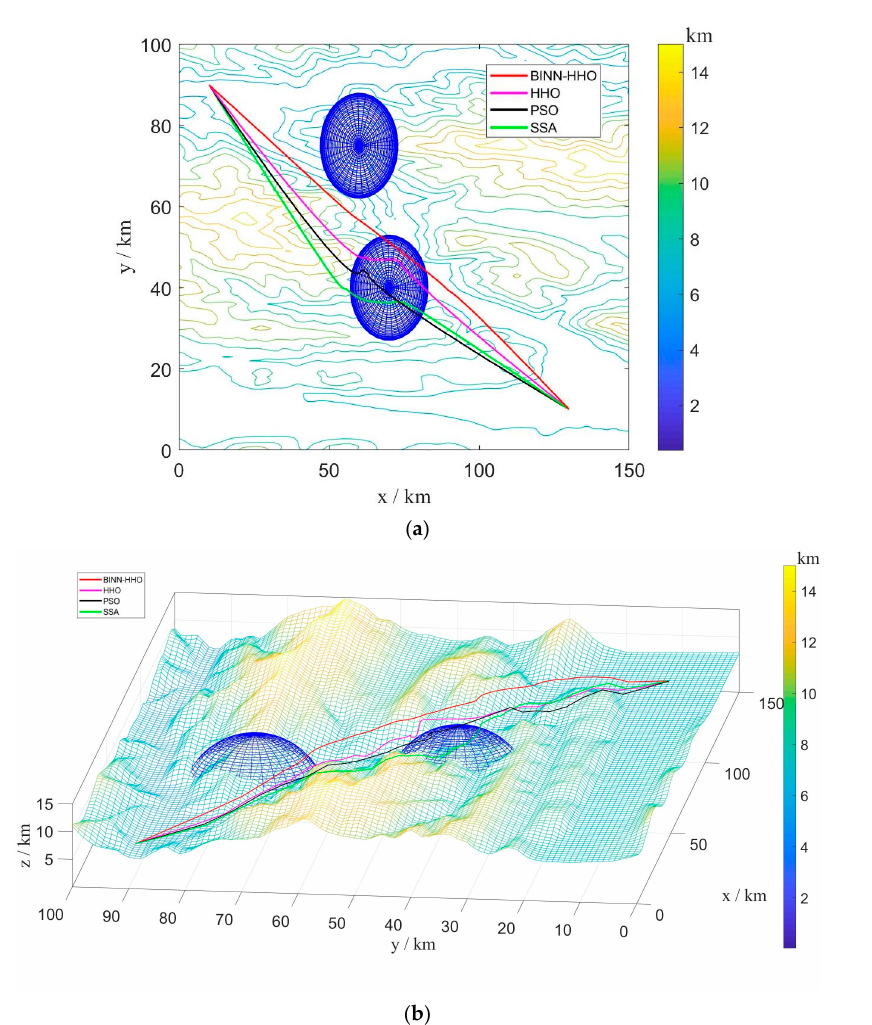
Figure 5. Single-UAV path planning based on BINN-HHO in a static environment: ( a ) 2D; ( b ) 3D.